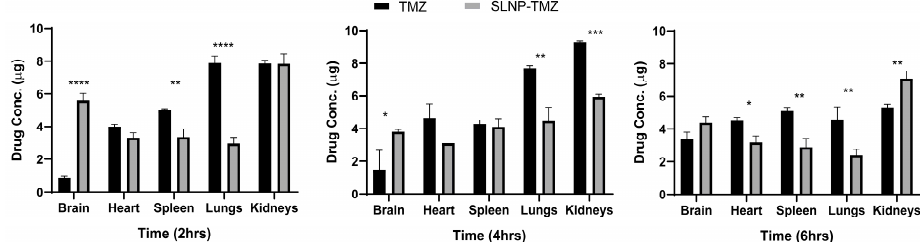
Figure 14. Temozolomide concentration in tissues at different time points (2 h, 4 h, 6 h) after intraperitoneal (i.p.) administration of TMZ and SLNP-TMZ ( n = 3). The biodistribution profiles of the temozolomide solution. * p ≤ 0.05, ** p ≤ 0.01, *** p ≤ 0.001, **** p ≤ 0.0001.